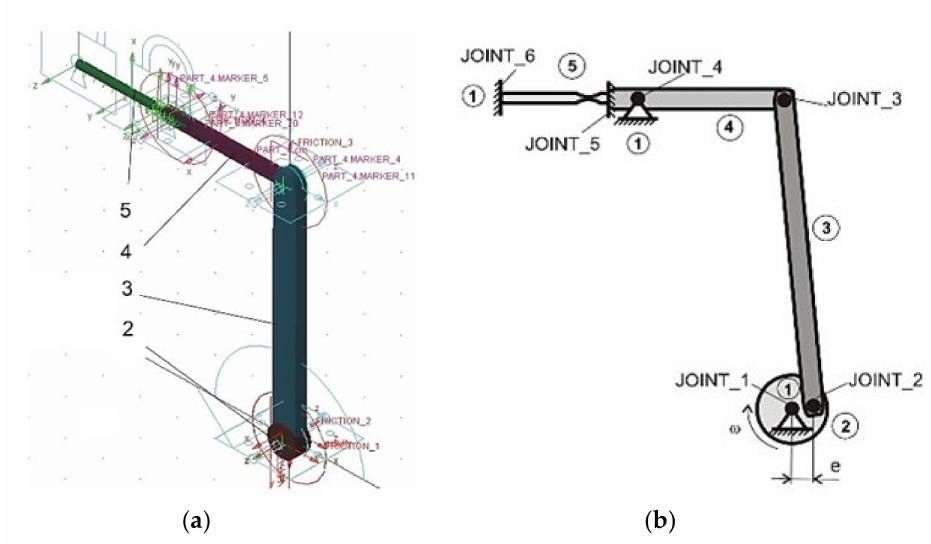
Figure 6. ( a ) Creating a virtual model of the mechanism for determining the machine dynamics;